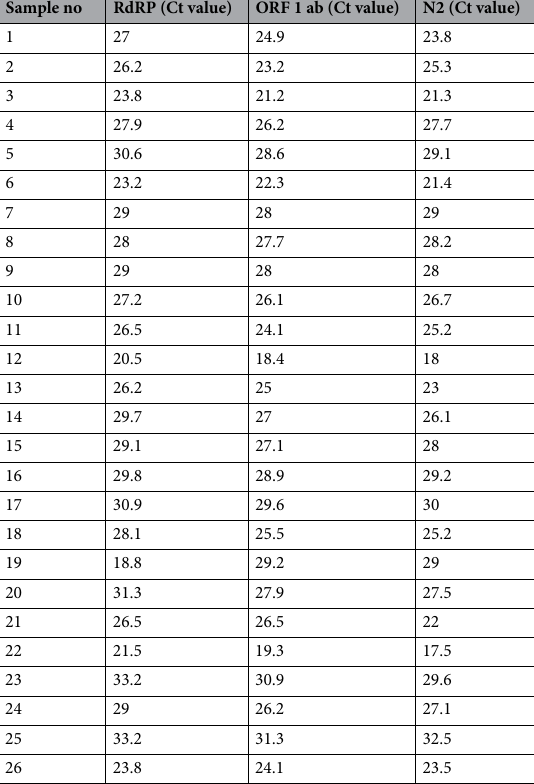
Table 1. Ct values of samples sequenced in this study with respect to different gene targets detected by COVID-19 Taqman qRT-PCR.